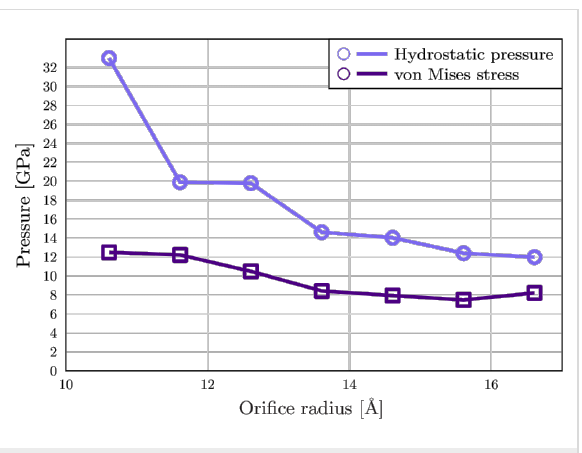
Figure 9: Hydrostatic pressure and von Mises stress at the onset of plasticity versus extrusion orifice radius. Lines are guides for the eye.